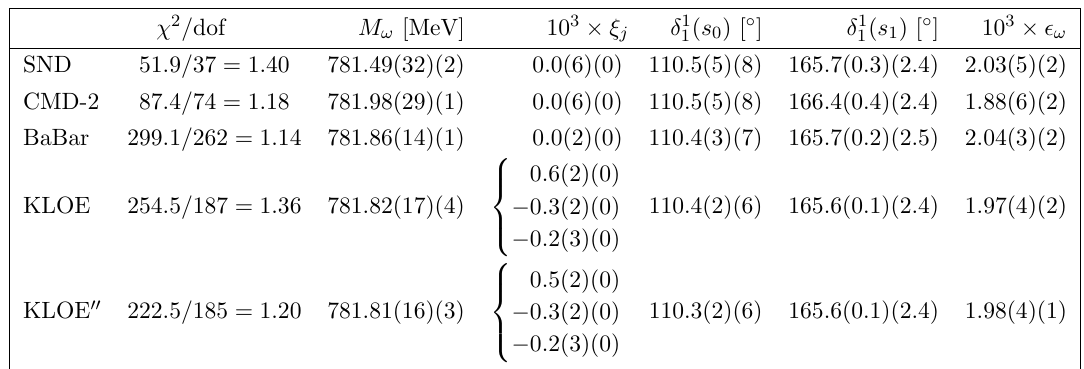
p (cid:31) 2 = dof, the second error is the